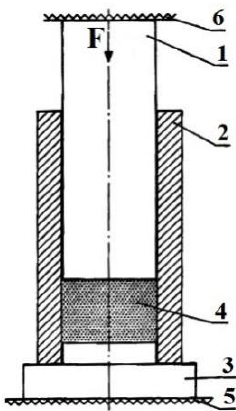
Figure 4. Pressing equipment—laboratory hand crafted briquetting press. (F—compressive force, 1—piston, 2—pressing chamber, 3—underlay, 4—material, 5—bottom pressure plate, 6—upper pressure plate).